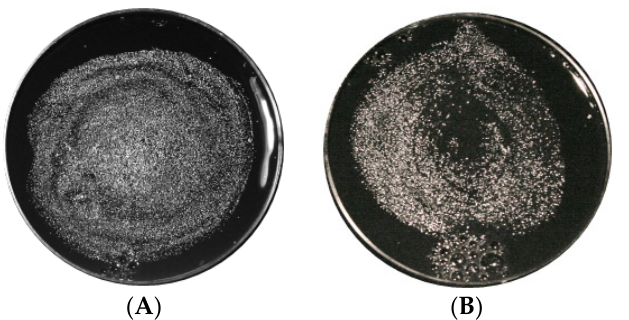
Figure 7. Effect of plasma treatment on XfDD strains (concentration 10 7 ) grown for 10 days ( A ) on the substrates before plasma treatment. Pictures were taken 15 days after plasma treatment. The picture shows the growth at 15 days from the plasma treatment of untreated samples ( A ) versus treated samples ( B ).